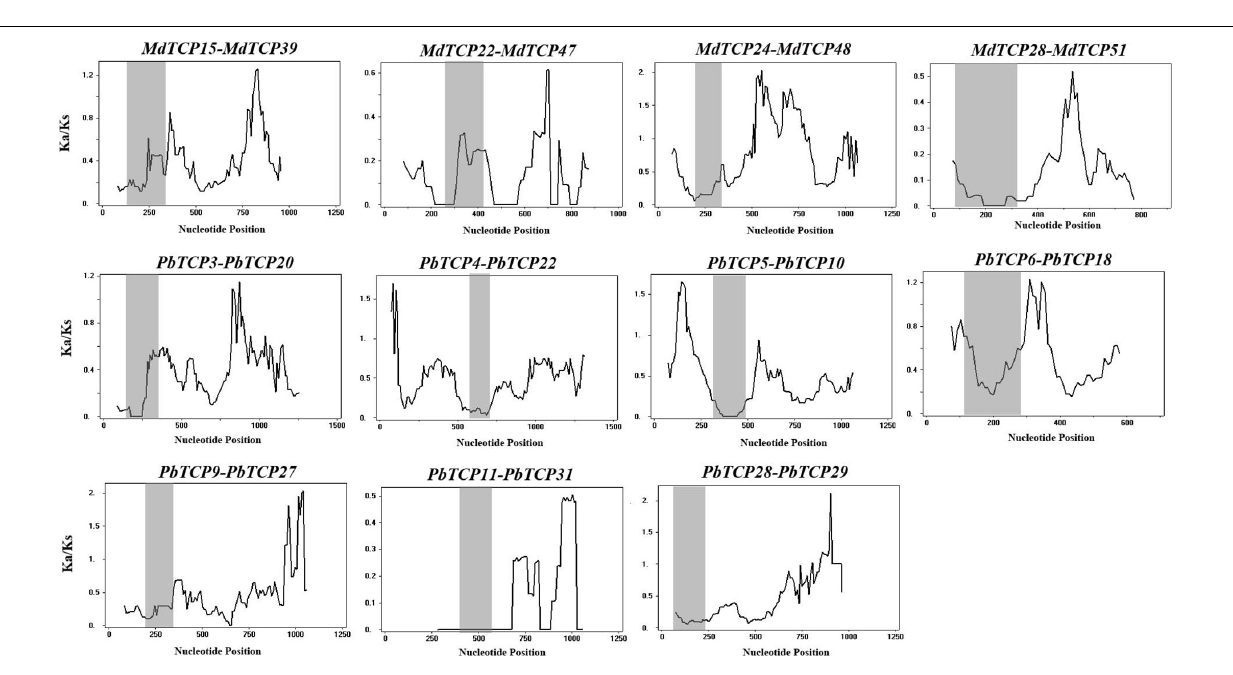
Frontiers in Genetics |